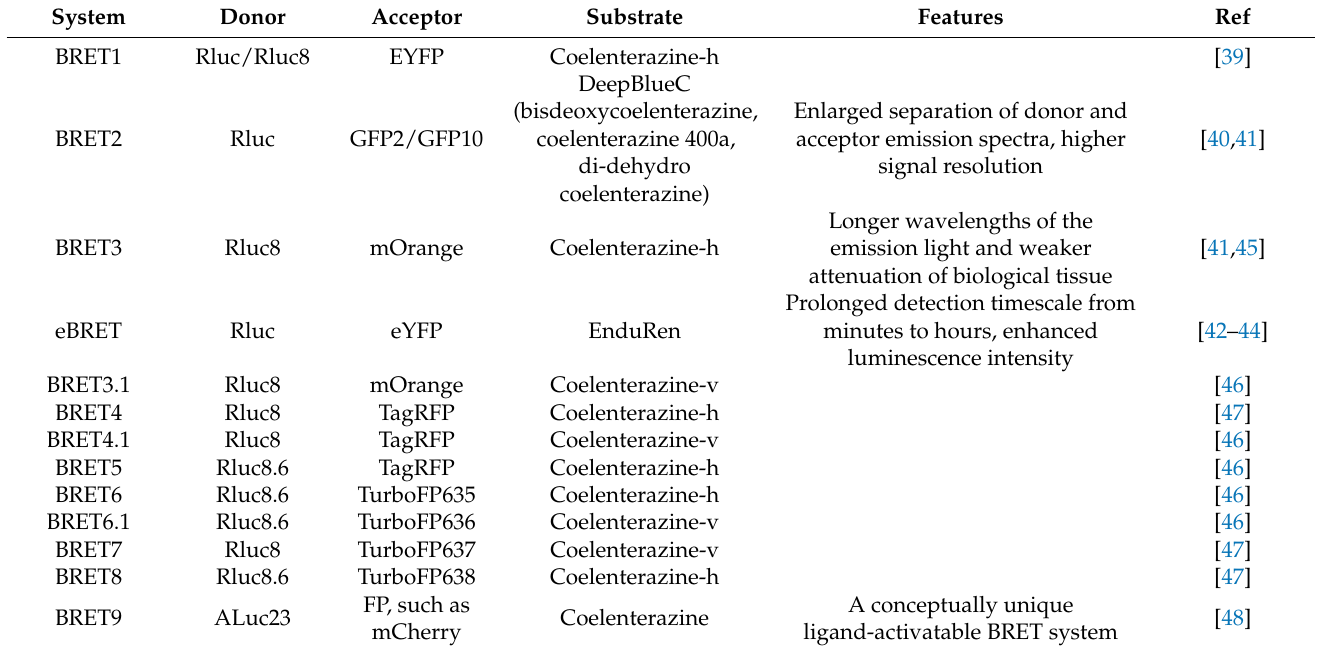
Table 1. Classic CTZ-consuming luciferase BRET